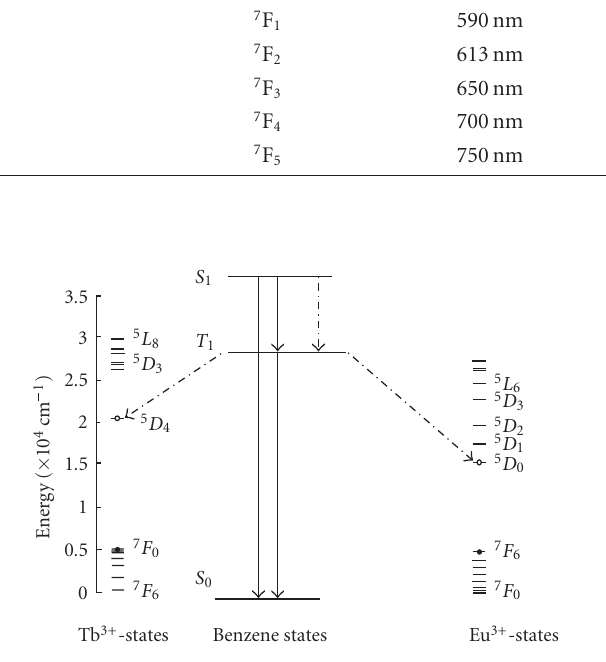
Figure 4: Energy level diagram for the system of cyclophane com- plex with Tb(NO 3 ) 3 and Eu(NO 3 ) 3 showing the likely routes of ET.